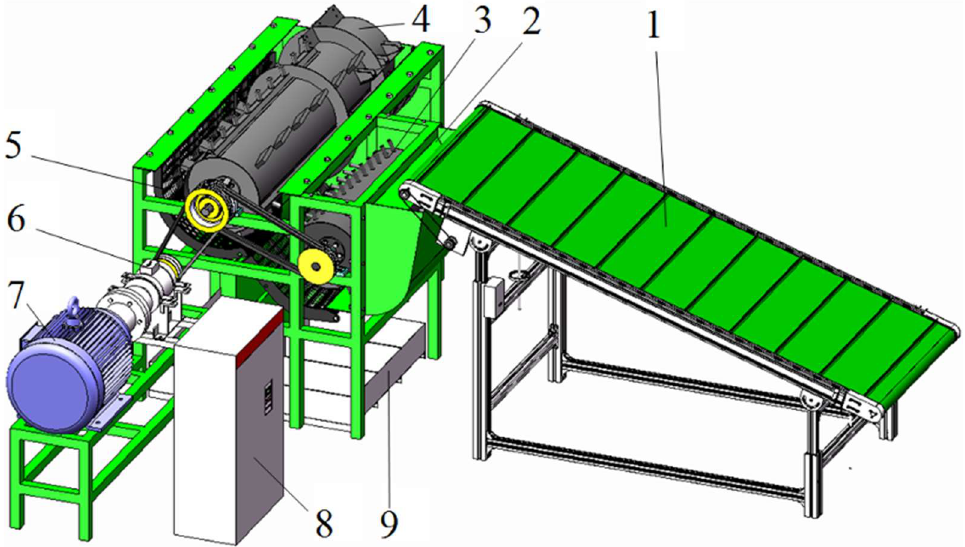
Figure 1. The 3D maize threshing test bench. (1) Feeding device; (2) feeding port; (3) tangential flow drum; (4) axial flow drum; (5) grid grating; (6) torque speed sensor; (7) motor; (8) electrical control cabinet; (9) grain collection box.